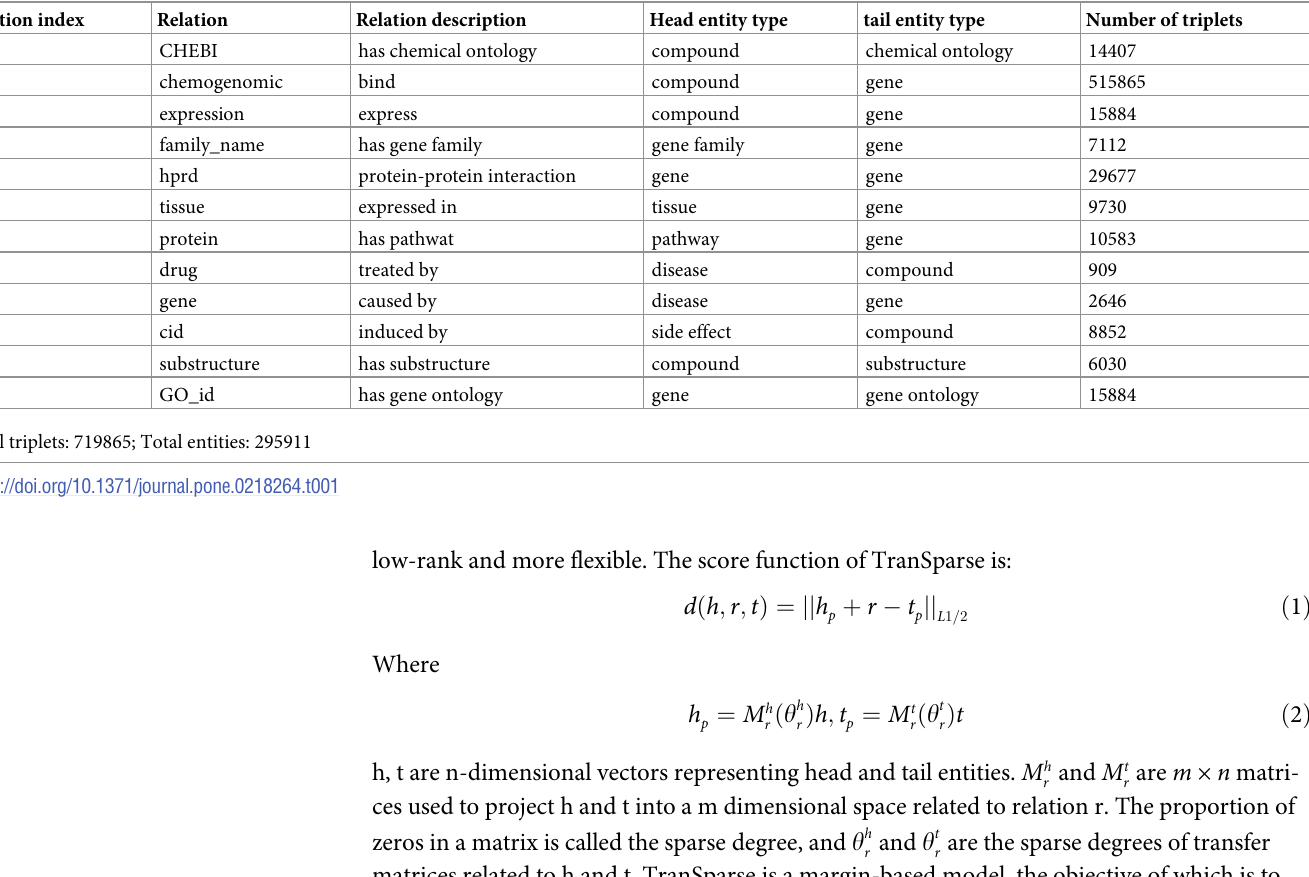
Table 1. The statistics of dataset